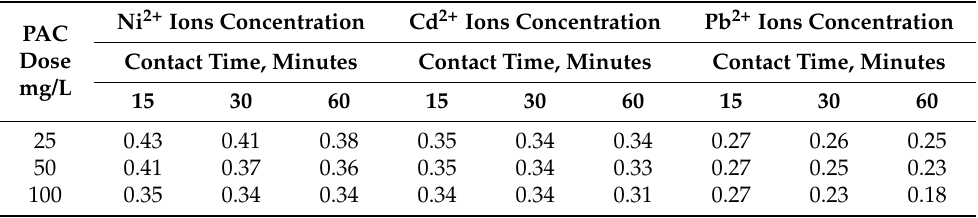
Table 5. Metal ions concentration (mg/L) in model water after adsorption process with PAC, initial metal ions concentration: 0.5 mg/L.